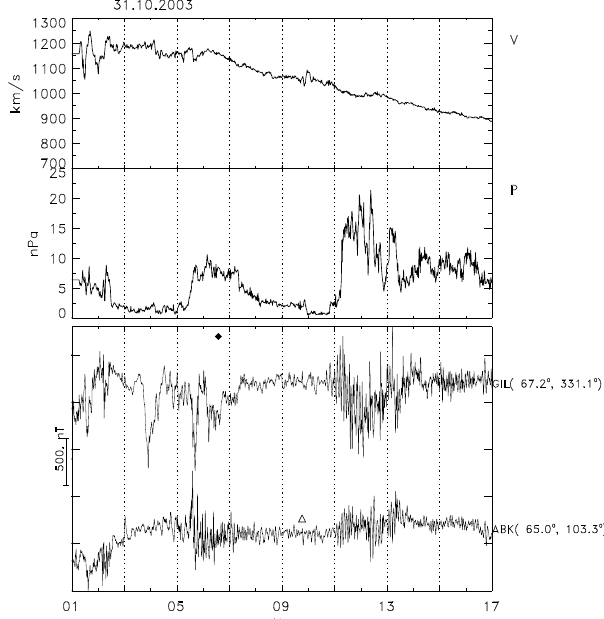
Fig. 7. Comparison of simultaneous variations of the SW velocity V [kms − 1 ], dynamic pressure P [nPa] as measured by ACE (time shifted by 26min), and X component [nT] at ABK (110 ◦ profile) during time interval 31 October,